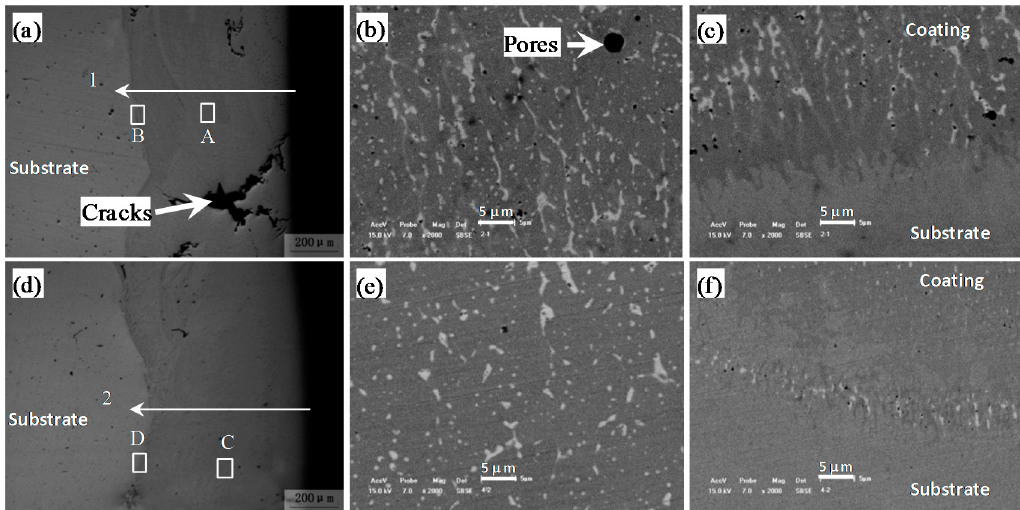
Figure 2. Cross-sectional microstructure for the laser cladding HEA coatings without and with Y 2 O 3 addition. ( a ) Cross section of coating without Y 2 O 3 ; ( b ) high magnification image from the middle of the coating as indicated by square A in Figure 2a; ( c ) high magnification image close to the interface as indicated by square B in Figure 2a; ( d ) cross section of coating with Y 2 O 3 addition; ( e ) high magnification image from the middle of the coating as indicated by square C in Figure 2d; ( f ) high magnification image close to the interface as indicated by square D in Figure 2d. Lines in (a) and (d) denote the linescan along which quantitative energy dispersive spectrometer (EDS) line analysis (Figure 3) was performed.